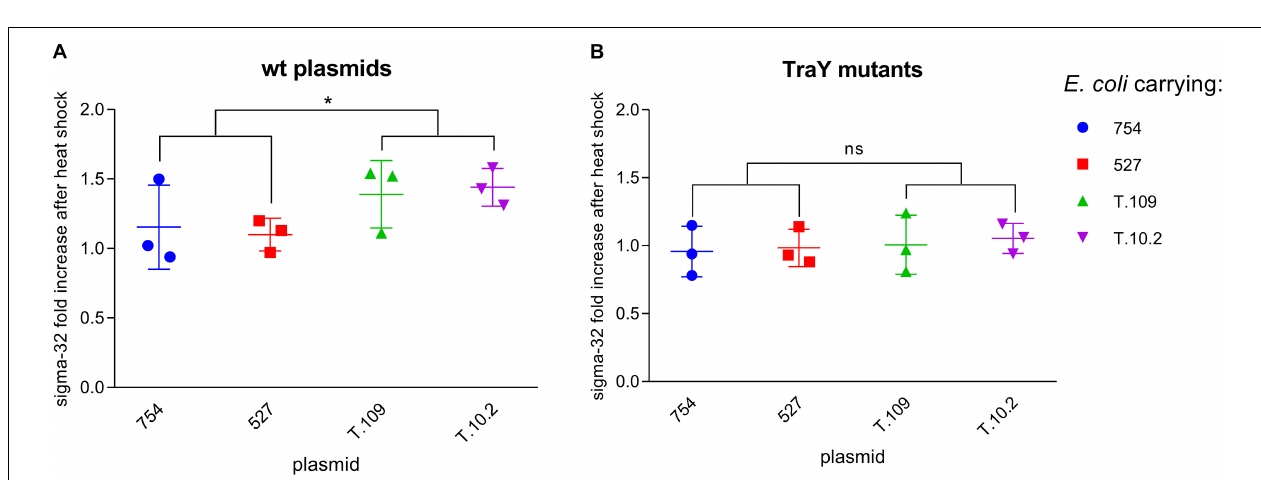
FIGURE 3 | Fitness cost of IncK1 and IncK2 plasmids measured at 37 and 42 ◦ C. All the measurements were performed in triplicate. Bars depict the mean and standard deviation. (A) Comparison of plasmid fitness cost by temperature. ∗ depict statistical significance ( p = 0.0201). (B) Comparison of plasmid fitness cost by plasmid type. ∗ depict statistical significance ( p = 0.0495).